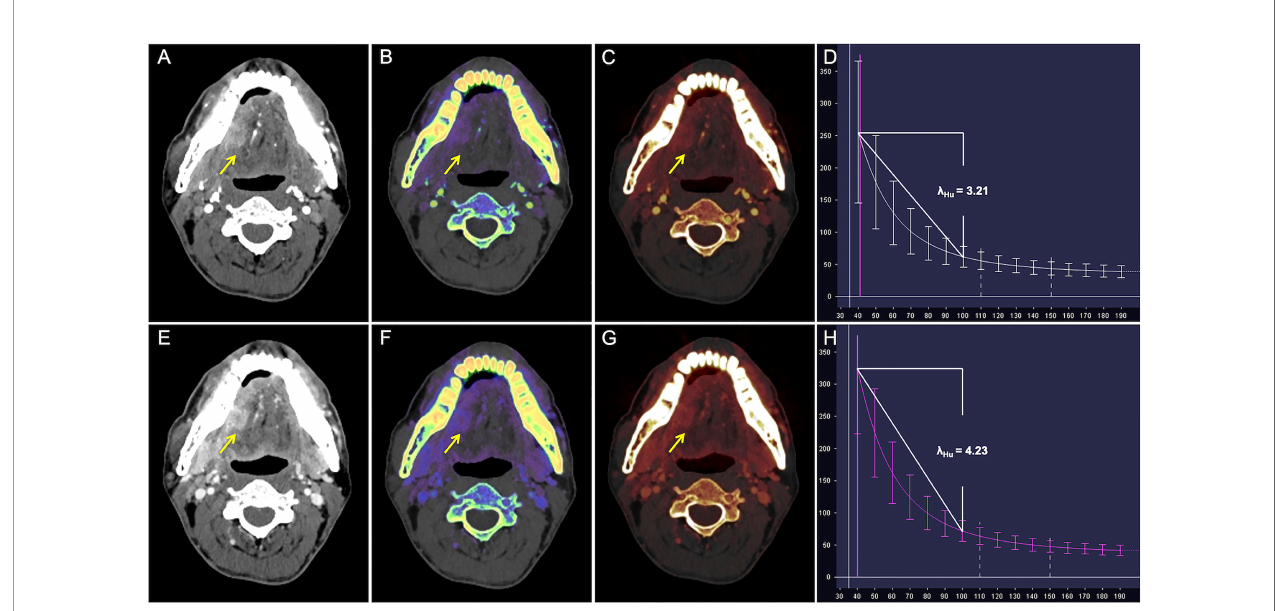
FIGURE 3 | CT images in a 50-year-old man with well-differentiated T2N0M0 OTSCC in stage II. (A – D) Arterial phase imaging of the primary tumor (arrow). (A) Contrast-enhanced 40-keV monochromatic image shows lesion with mean CT value of 255.26 HU. (B) Effective atomic number map shows lesion with mean Z eff value of 8.70. (C) Iodine-based pseudo-colorized image shows lesion with mean IC of 3.16 mg/ml. (D) Spectral Houns fi eld unit curve shows lesion with mean l Hu of 3.21 HU/keV. (E – H) Venous phase imaging of the primary tumor (arrow). (E) Contrast-enhanced 40-keV monochromatic image shows lesion with mean CT value of 325.53 HU. (F) Effective atomic number map shows lesion with mean Z eff value of 9.17. (G) Iodine-based pseudo-colorized image shows lesion with mean IC of 3.50 mg/ml. (H) Spectral Houns fi eld unit curve shows lesion with mean l Hu of 4.23